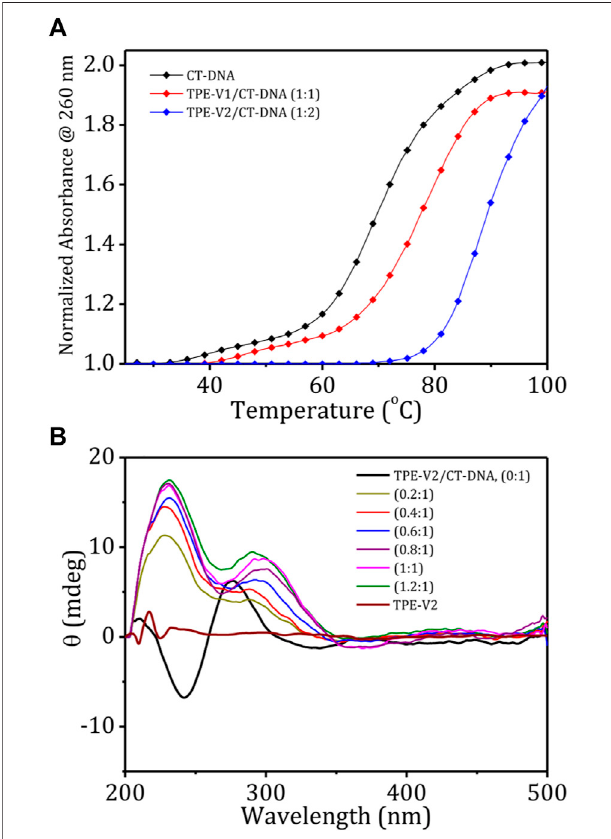
FIGURE 2 | (A) Thermal denaturation curves of CT-DNA in the absence and presence of TPE-V1 and TPE-V2 ; (B) CD spectra of CT-DNA (100 μ M), TPE-V2 (100 μ M) and changes in the CD spectrum of CT-DNA with the sequential addition of TPE-V2 (0 – 1.2 M equivalent).